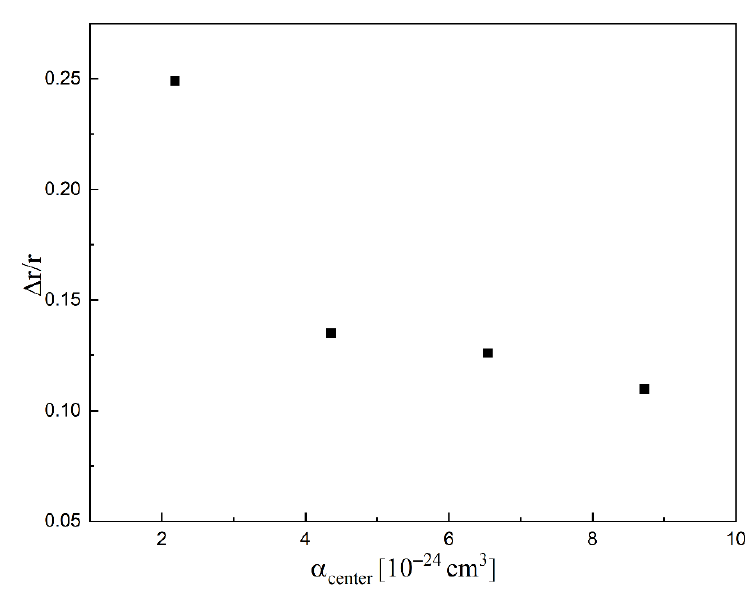
Figure 6. Dependence of the ∆ r/r on α center for SiH 3 Cl, SiH 2 Cl 2 , SiHCl 3 , SiCl 4 . Table 2. Relative changes in the bond length for a negative ion and its neutral, Δr/r , adiabatic elec- tron affinity, AEA, and relative changes in the H-Si-Cl bond angle for a negative ion and its neutral state, Δ ∠ / ∠ . Calculated using the DFT/B3LYP for chlorine-substituted silanes. Compound